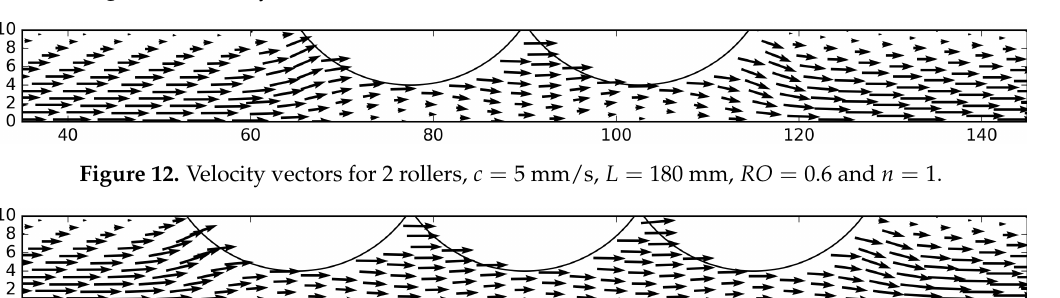
Figure 11. Velocity vectors for 1 roller, c = 5 mm/s, L = 180 mm, RO = 0.6 and n = 1.